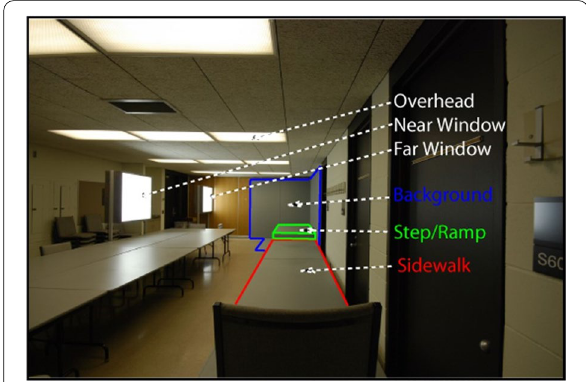
Fig. 3 The constructed sidewalk and room used for the steps and ramps studies. Adapted from Legge et al.